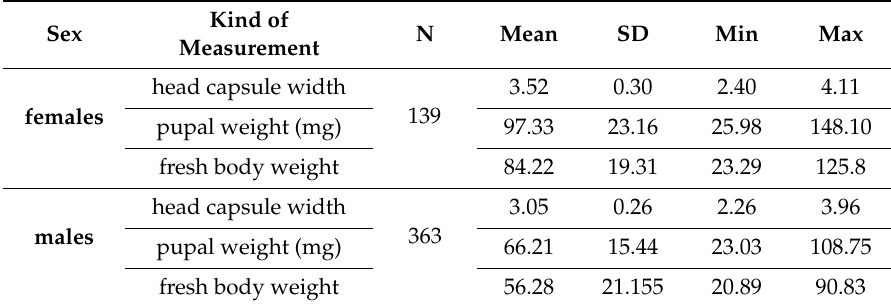
Table A2. Measurements dependent on sex within the pharate dataset.